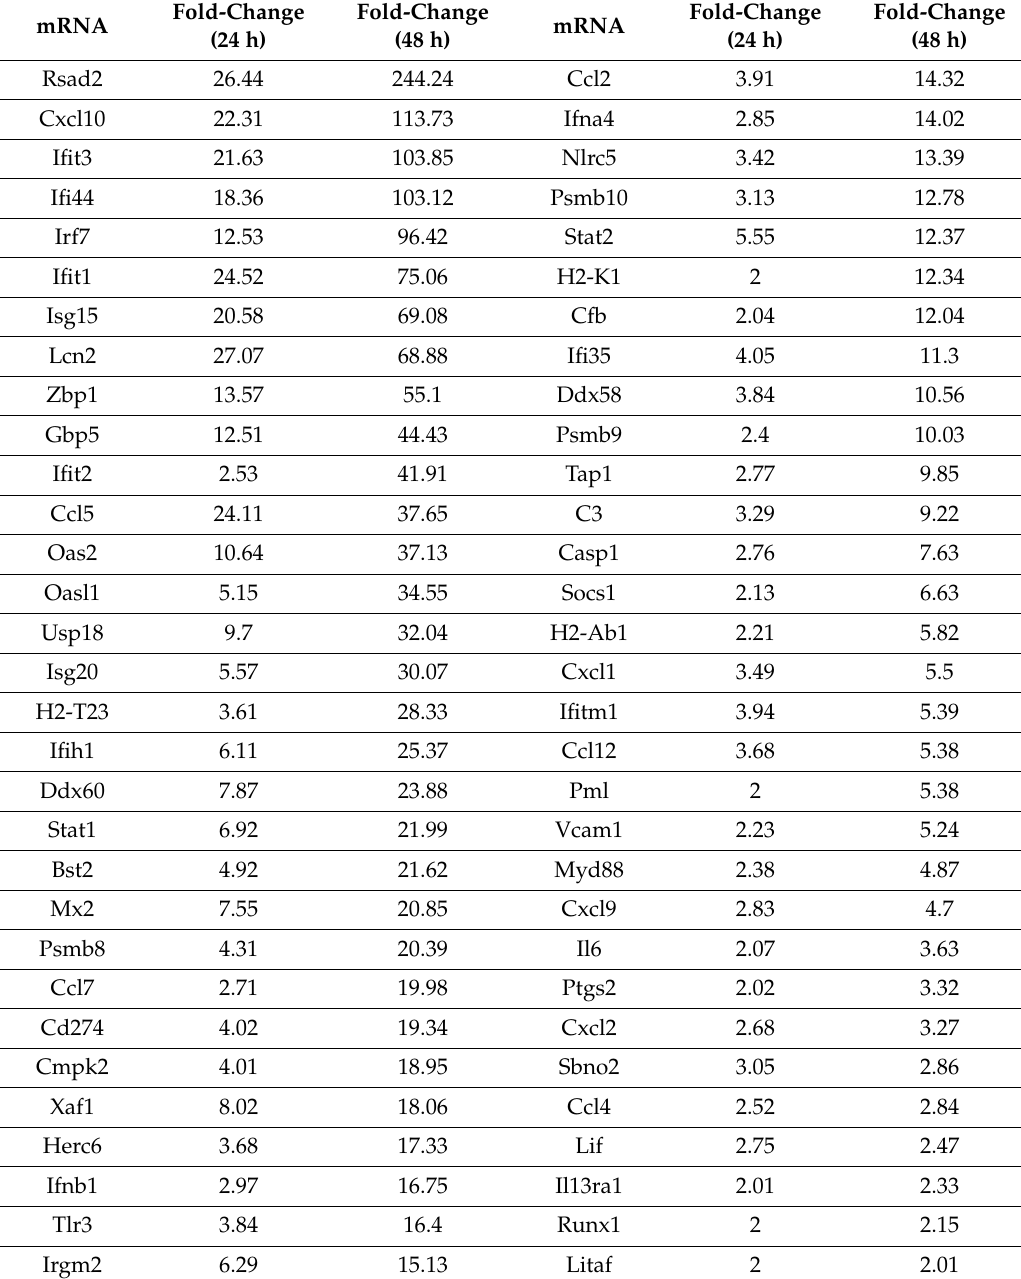
Table 6. Upregulated mRNAs in ZIKV-infected neurons at 24 and 48